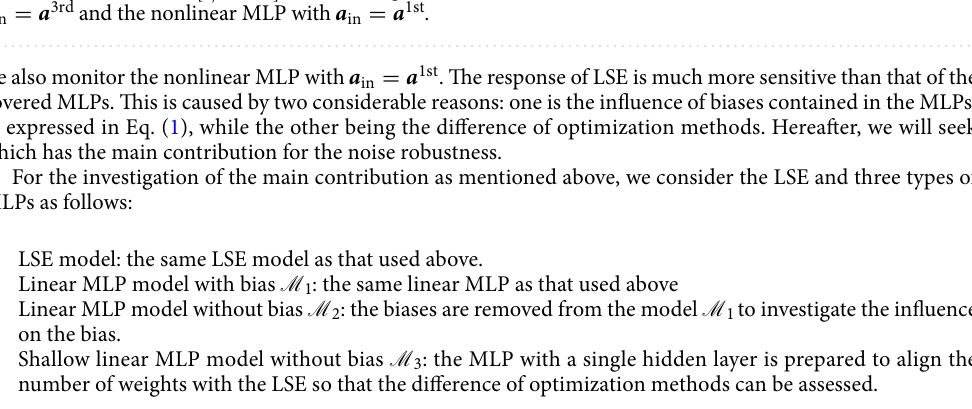
Figure 4. Robustness for noisy input of POD coefficients estimation. ( a ) Dependence of the increase ratio of the L 2 error norm ε/ε [ 1 / SNR = 0 ] on noise magnitude. ( b ) a out with 1 / SNR = 0.1 for the linear models with a a 3rd and the nonlinear MLP with a a 1st in = in =